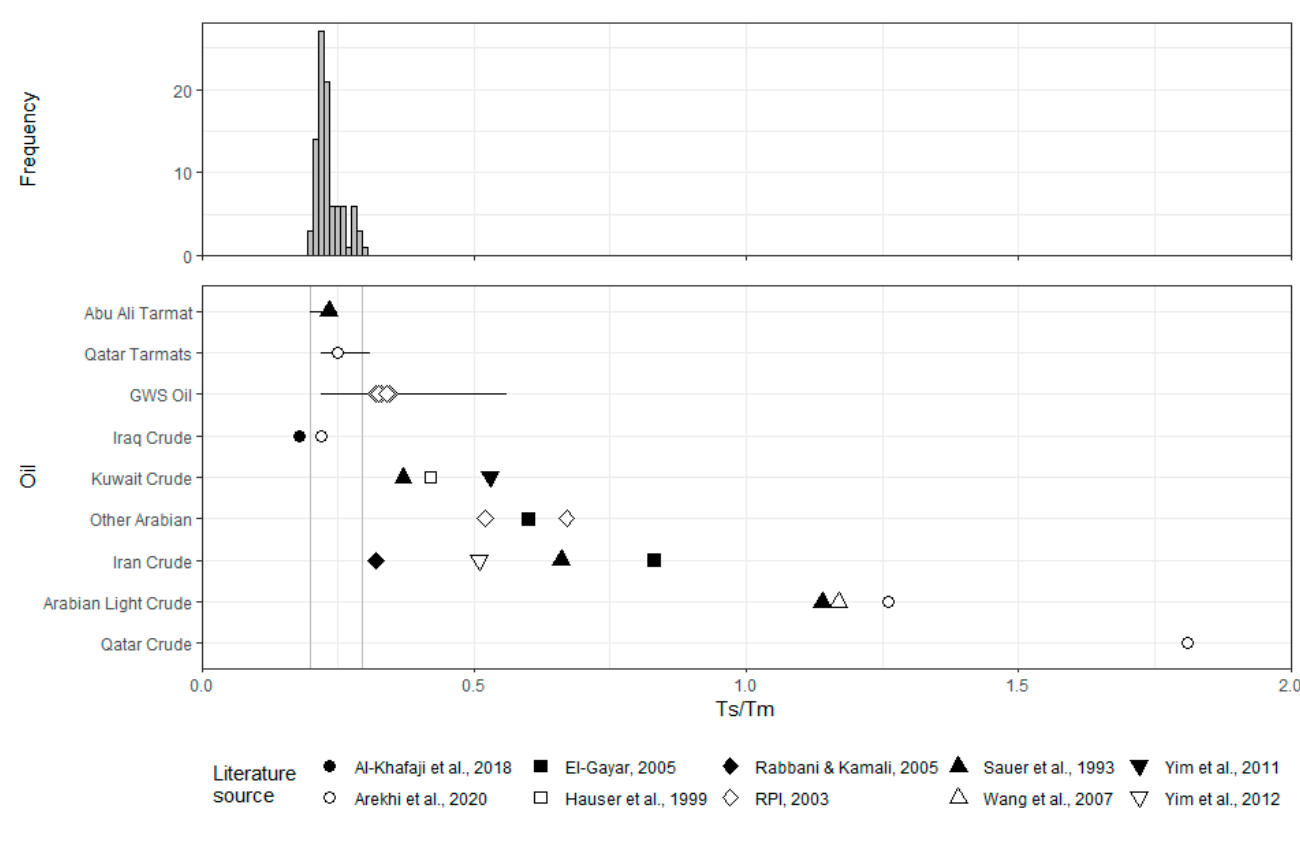
Figure 6. Top: Histogram of the diagnostic ratio Ts/Tm for the 94 samples of asphalt pavement or heavily oiled sediments from Abu Ali Island collected in 2020. Bottom: Possible source oils in the region and tarmats from Abu Ali Island and Qatar as listed in Table 1. Black horizontal bars represent ranges of reported values. The grey vertical bars represent the range in values for the 2020 Abu Ali Island samples. The open diamonds for GWS oil represent the various GWS samples in Table 1, and the horizontal bar represents the range in values for the 2240 samples from 2002–2003.